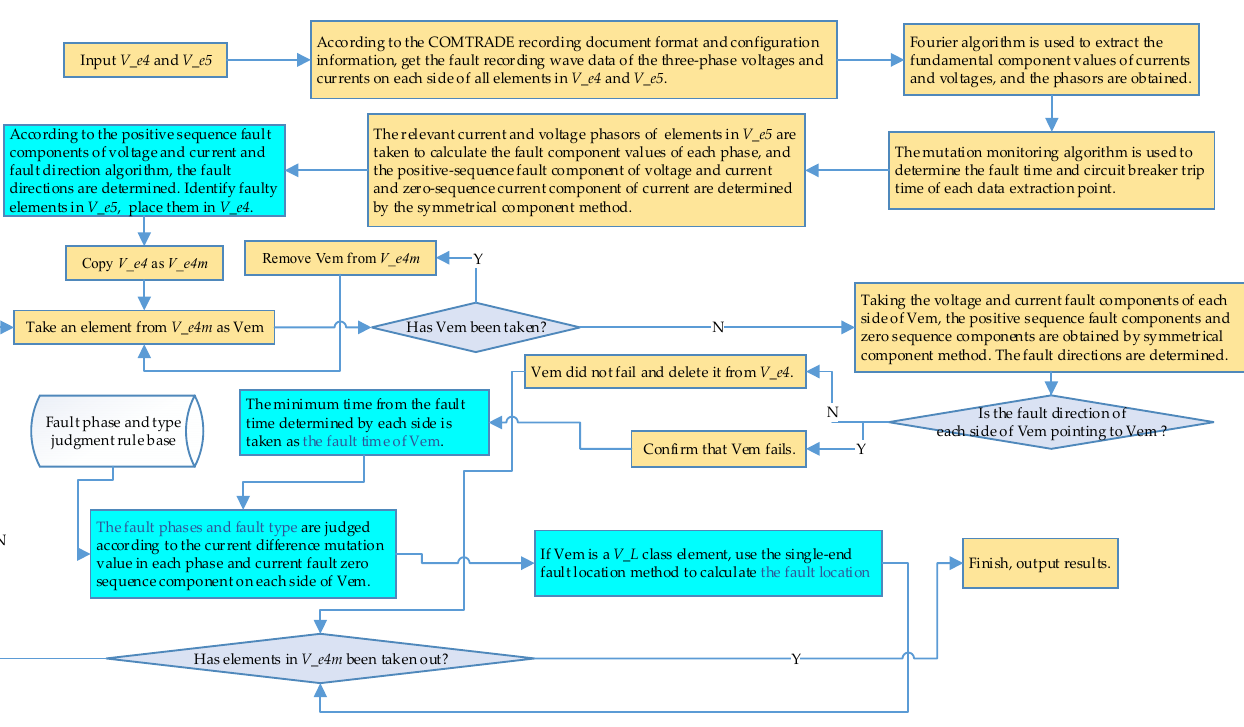
Figure 9. Batch processing system flow chart.